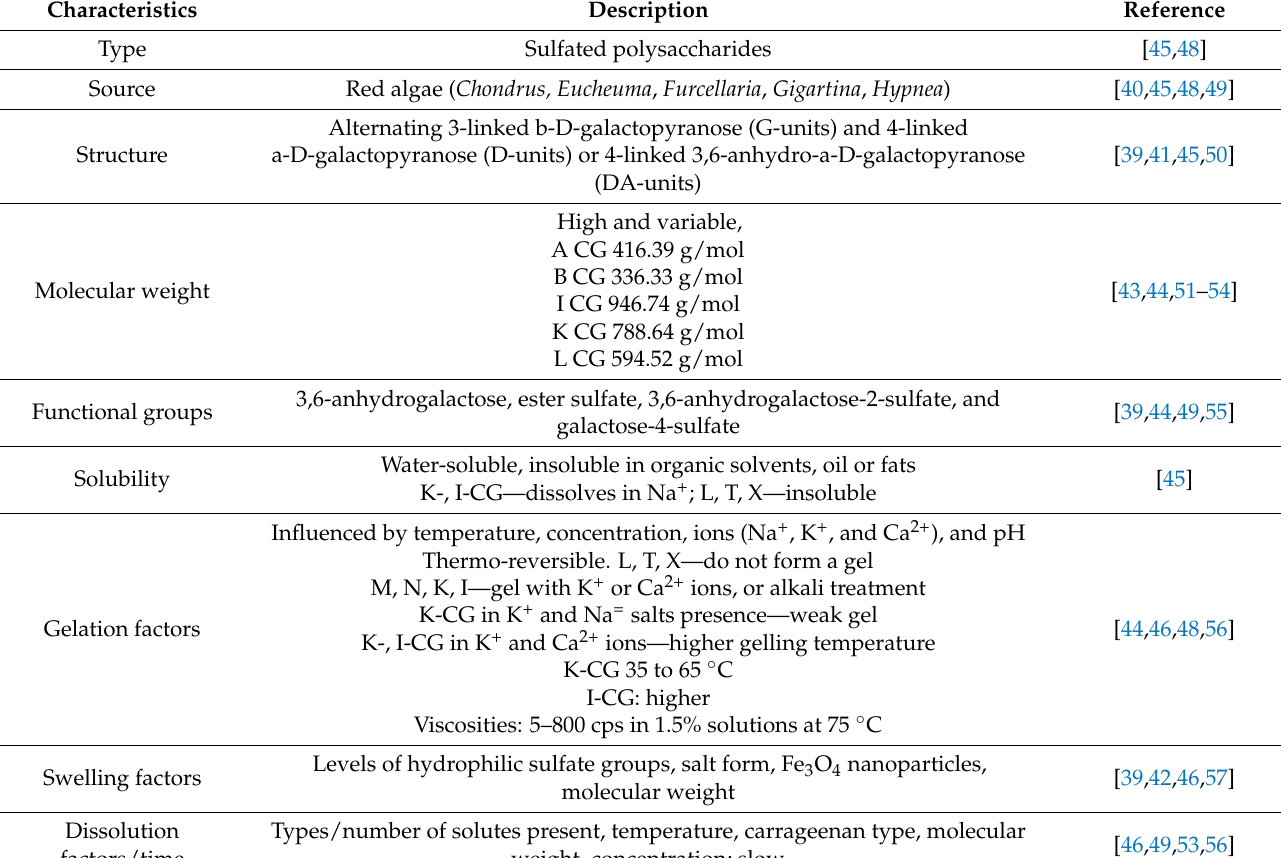
Table 1. General characteristics of